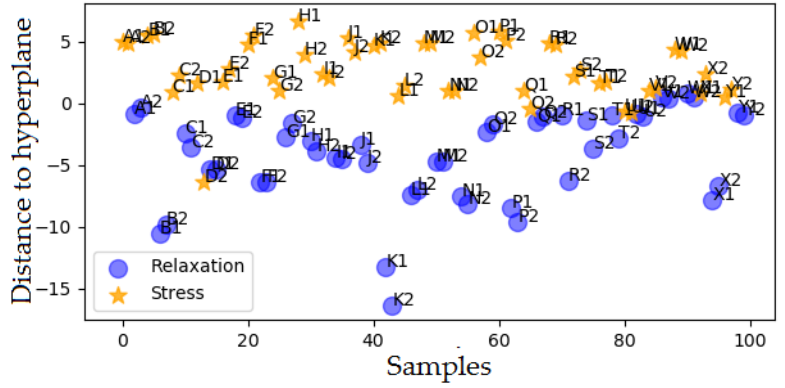
Figure 18. The graphical response of the HRV signal classification algorithm.